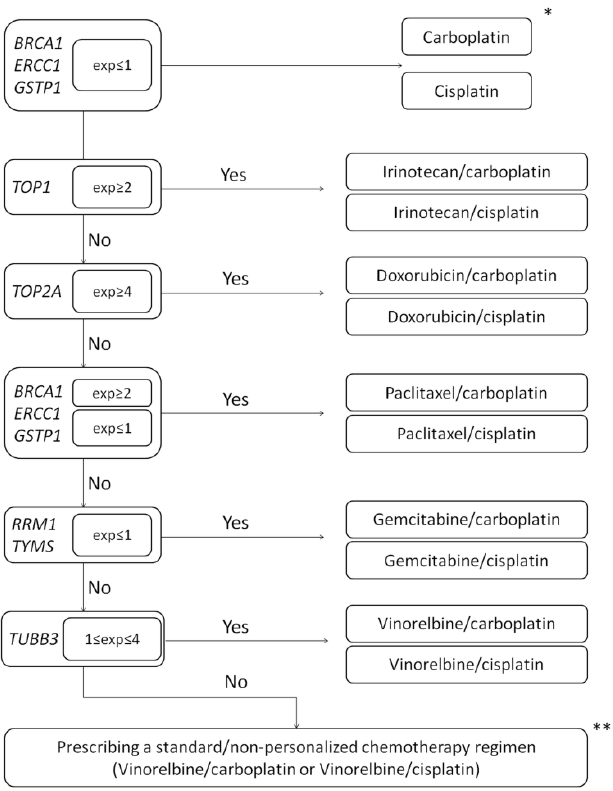
Figure 1. Algorithm for choosing a personalized regimen for adjuvant chemotherapy in patients with NSCLC, depending on the level of expression of chemosensitivity genes. Note: * According to international clinical guidelines, adjuvant chemotherapy is based on platinum-containing drugs, so the first drug in the regimen is cisplatin or carboplatin. ** If patients were unable to choose a personalized chemotherapy regimen, then such patients received a standard treatment regimen and were not included in the